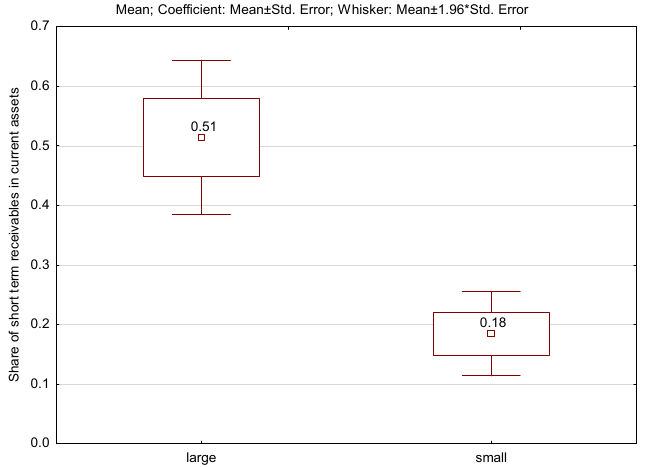
Mean; Coefficient: Mean±Std. Error; Whisker: Mean±1.96*Std. Error